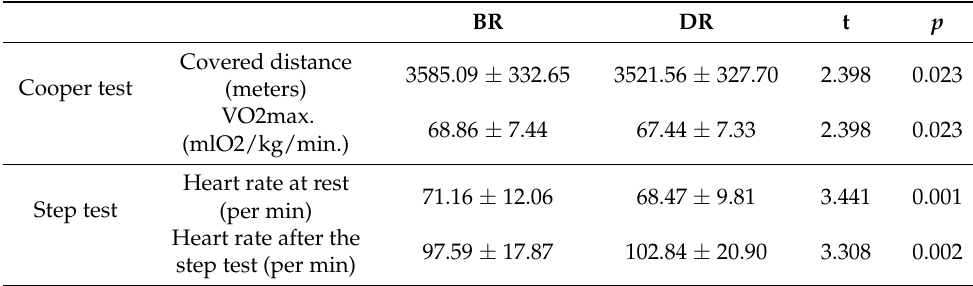
Table 4. Physical performance (mean ± SD) as estimated by the Cooper test and Step test. Values before (BR) and during (DR) Ramadan.